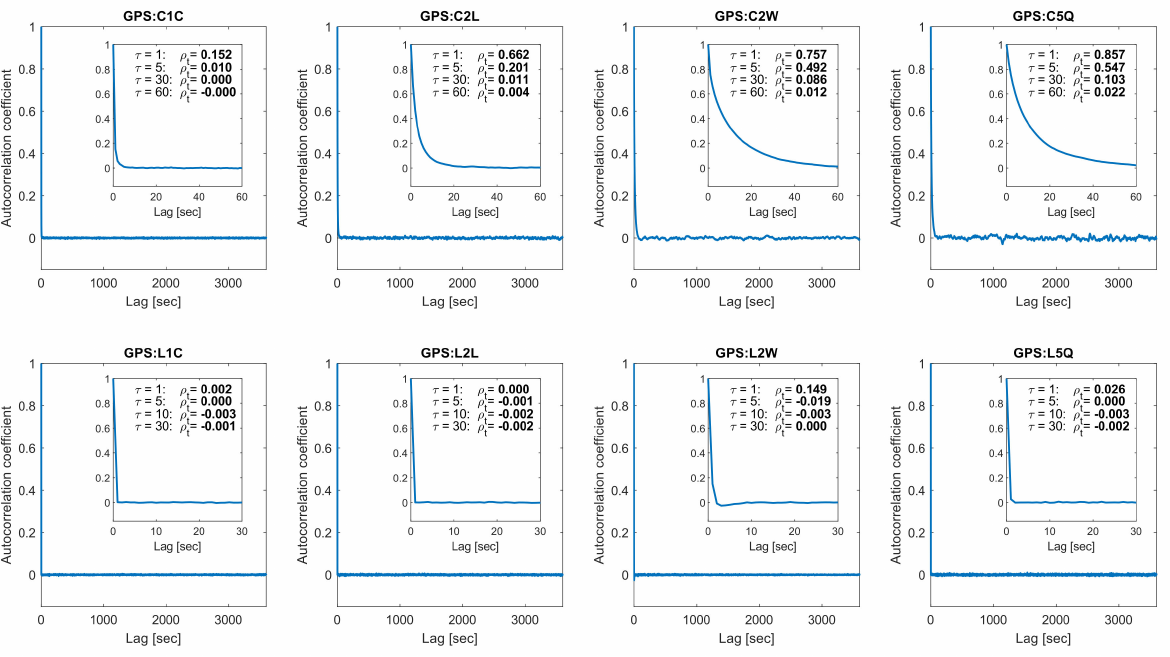
Figure 4. Sample autocorrelation coefficients for GPS observations (2019 DOY: